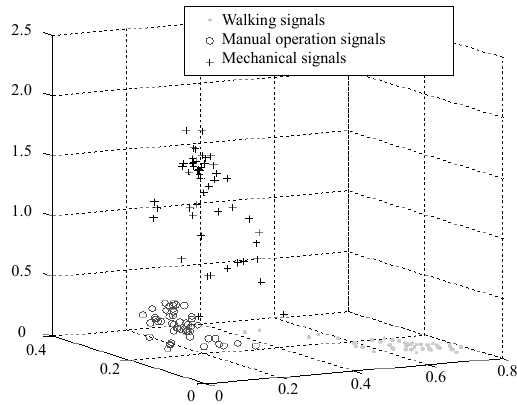
Fig. 8 Feature distribution of three signals.